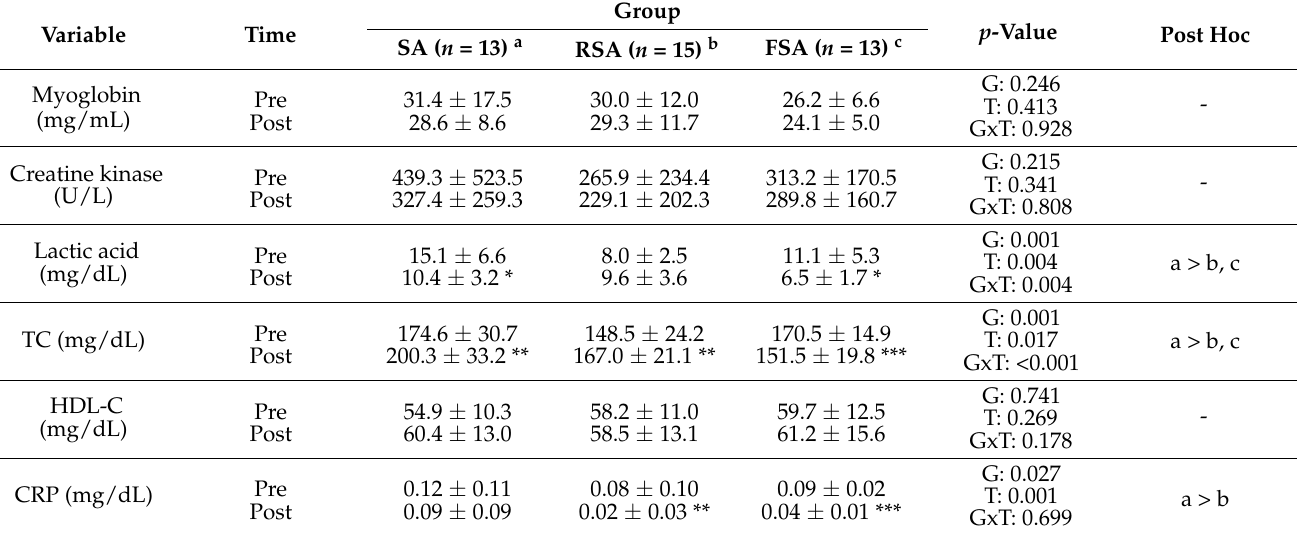
Table 4. Measurements of plasma components parameters by group and time.